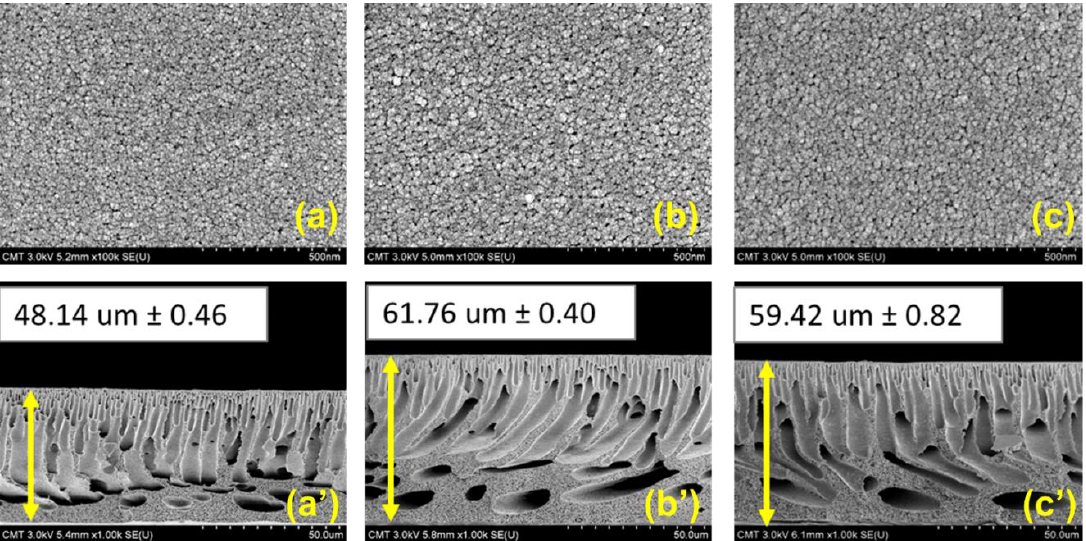
Figure 4. FESEM images of ( a , a ’) PES; ( b , b ’) PES PDA0.3 ; ( c , c ’) PES Ag-PDA0.3 . Surface images magnification = ×100k; cross-sectional images magnification = ×1k.